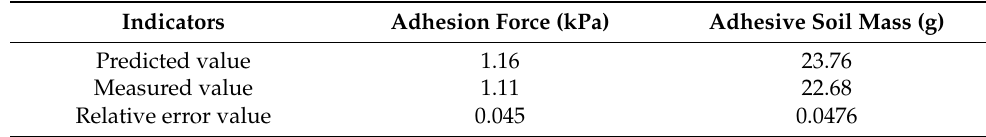
Table 6. Results of the verification